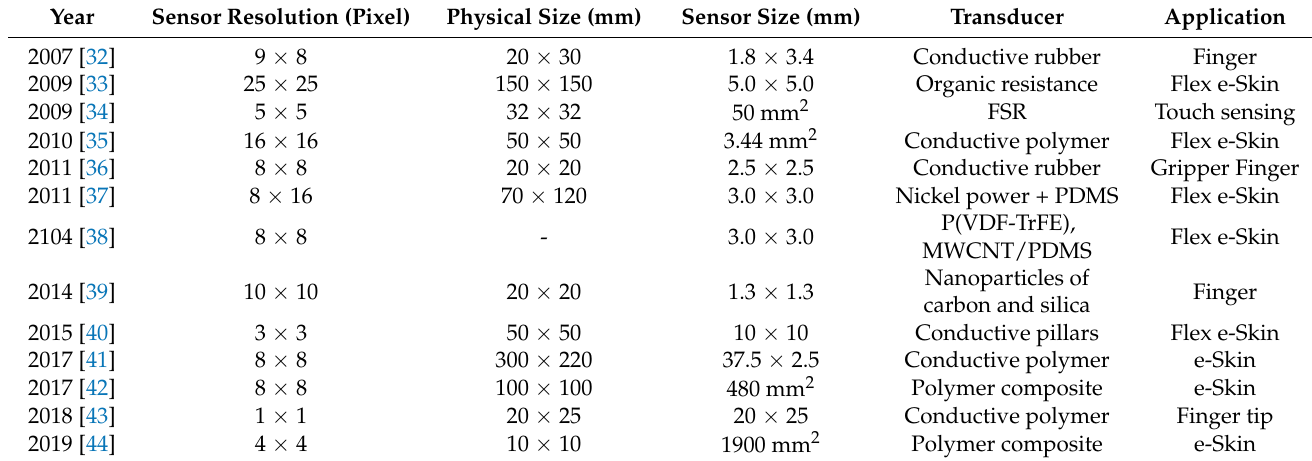
Table 1. Piezoresistive tactile sensor array for the anthropomorphic robot.